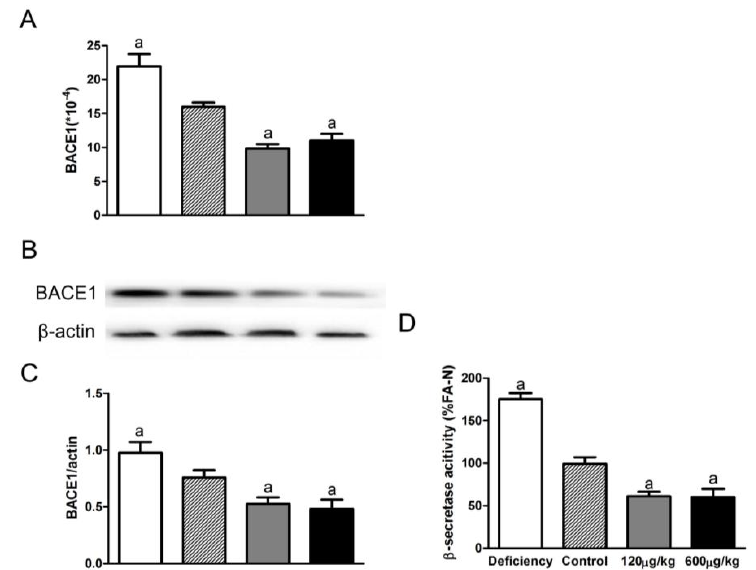
Figure 3. Folate inhibited BACE1 expression in APP/PS1 mice. BACE1 mRNAs and proteins in the brains of APP/PS1 mice were evaluated by qRT-PCR and Western blot analysis. The β-secretase activity was determined by ELISA. Representative bands and quantitative analysis revealed that folic acid treatment led to down-regulation of mRNA ( A ) and protein ( B , C ) expression of BACE1 and its activity ( D ). Folate deficiency led to up-regulation of BACE1 expression and activity. The data were expressed as means ± SD values, n = 6 animals/group. a: p < 0.05 versus the control